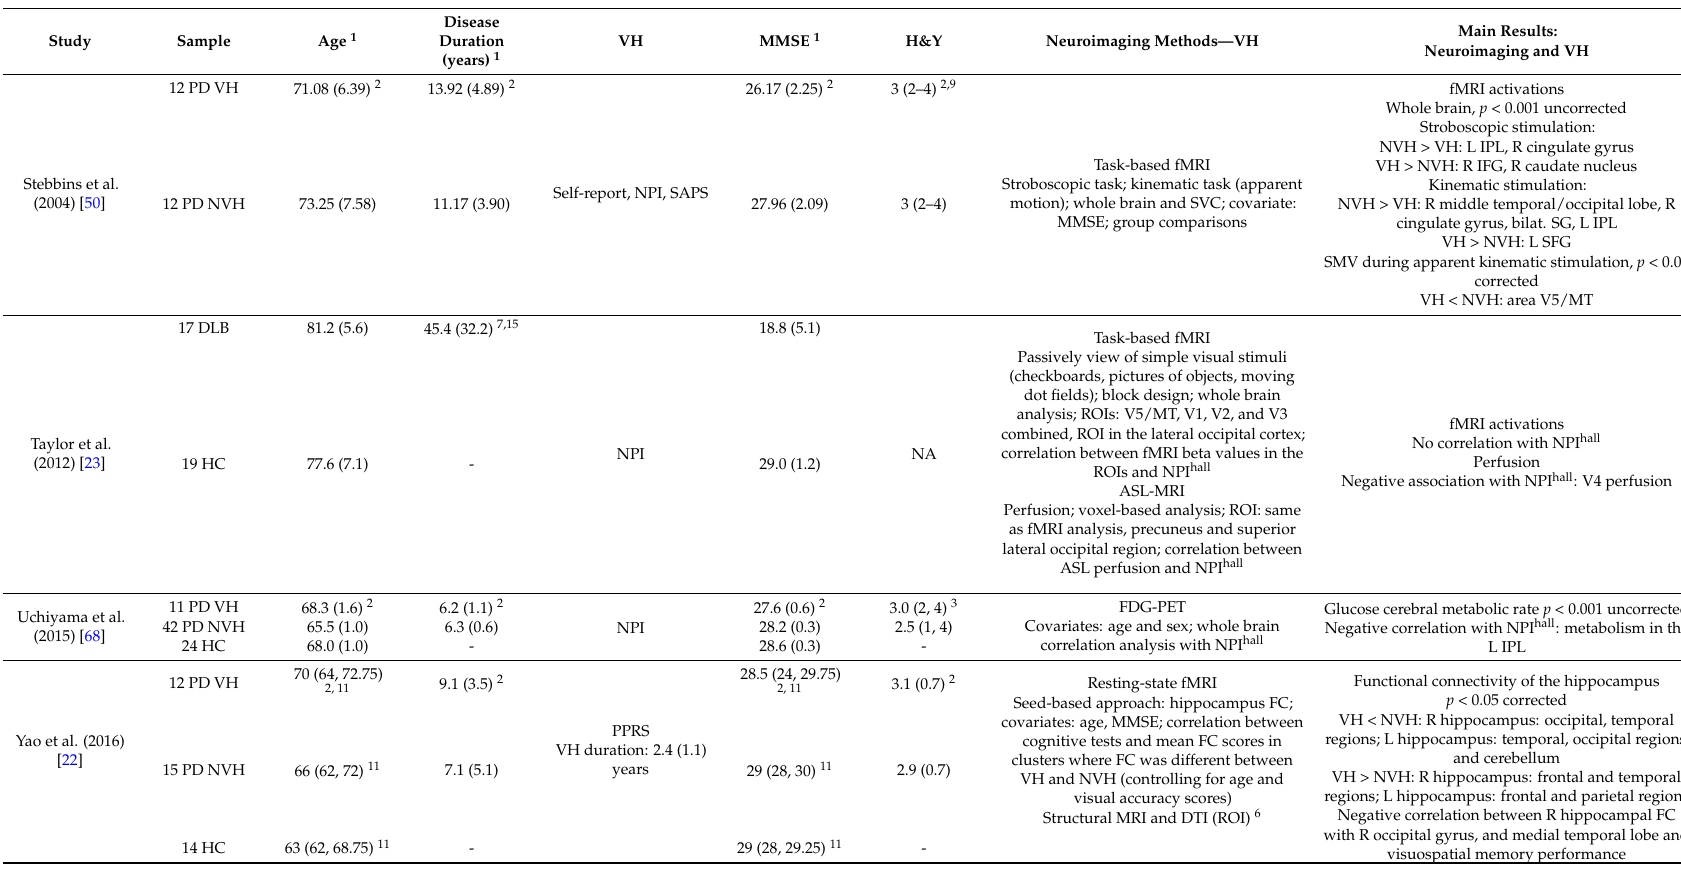
Task-based fMRI Stroboscopic task; kinematic task (apparent motion); whole brain and SVC; covariate: